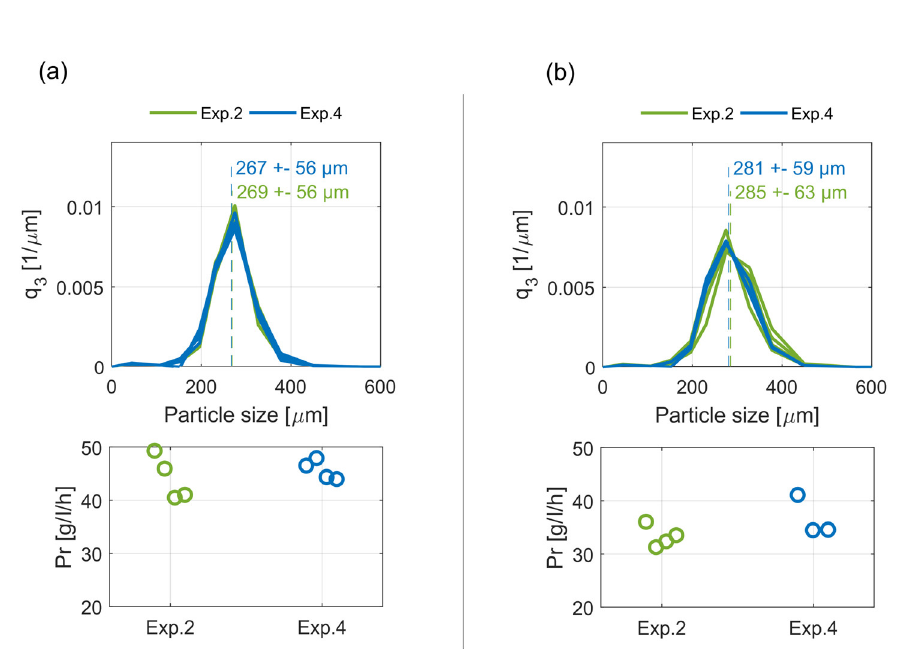
Figure A1. Steady-state crystal size distributions, q 3 , with their respective mean values and standard deviations as well as the corresponding productivities, Pr, of crystallizer C2 ( a ) and C1 ( b ) for Exps. 2, 4.